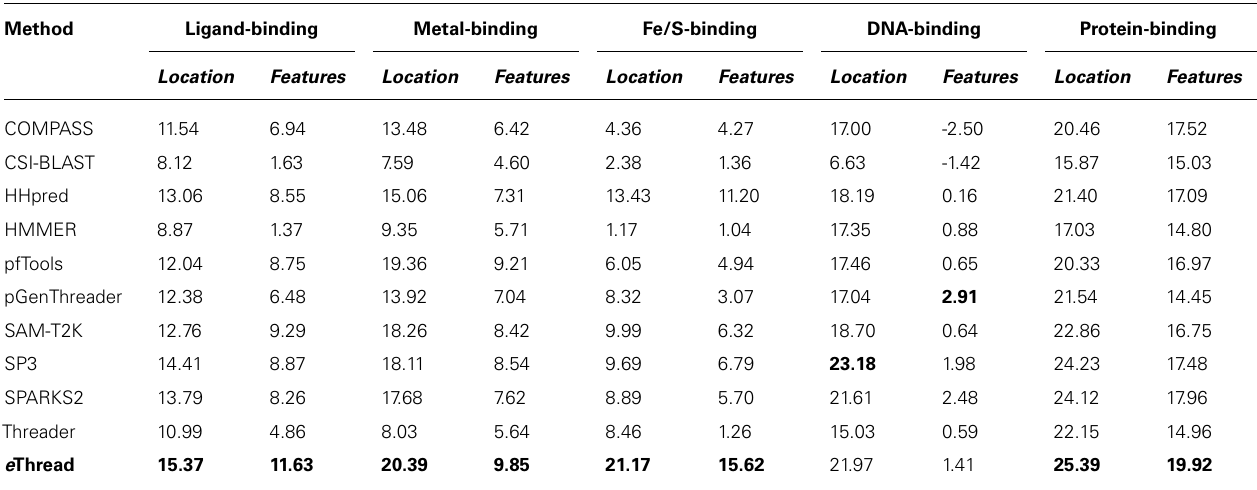
Location and Features as defined in Section “Methods.” For each column, the best separation of positives and negatives is highlighted in